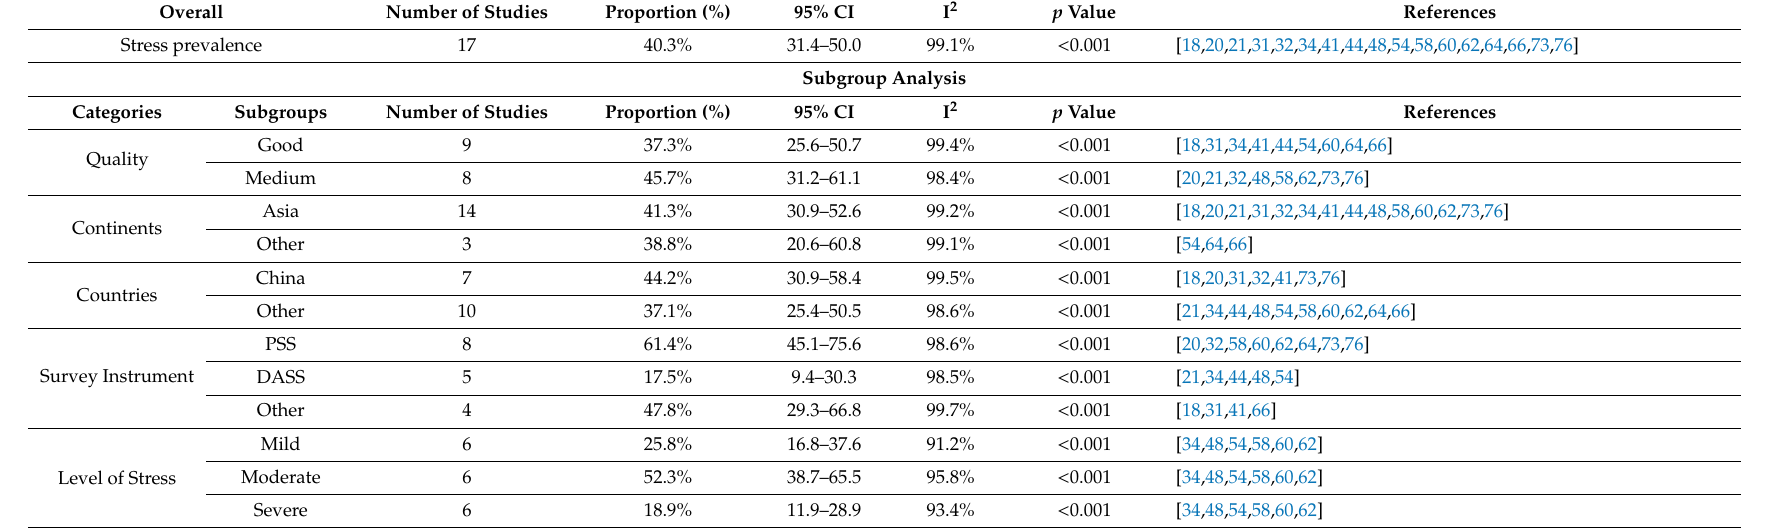
Table 3. Subgroup analyses of stress across di ff erent